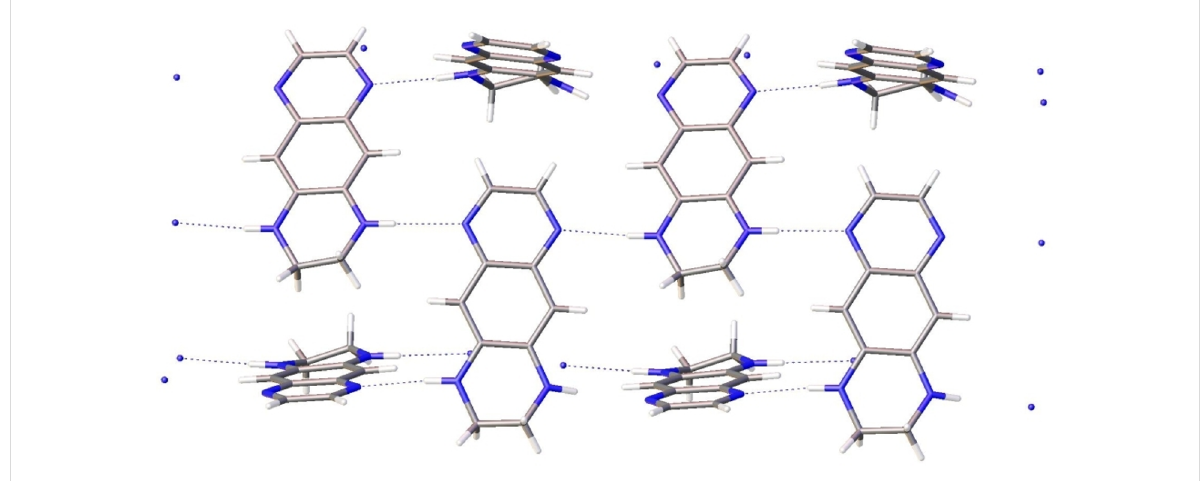
Figure 9: View of the supramolecular array generated by 3 in the solid state. Color coding: nitrogen, blue; carbon, grey.